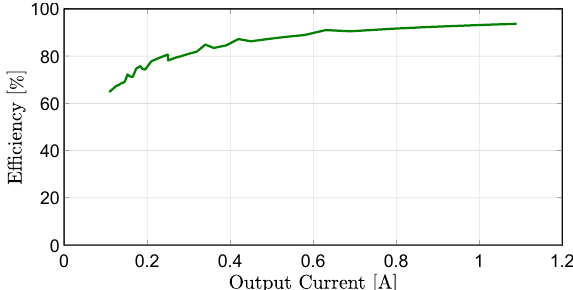
Figure 20. The efficiency of the proposed ´cuk converter balancing